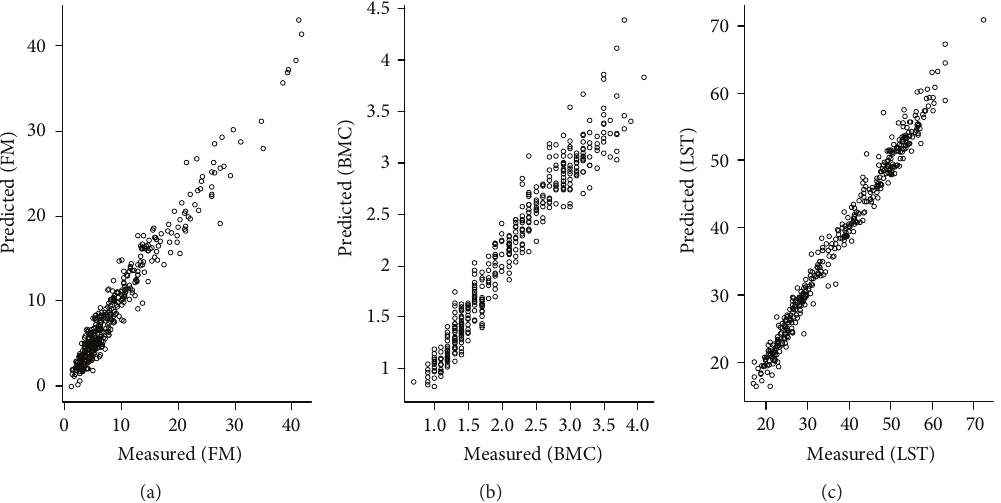
Figure 2: Scatterplot of predicted and actual fat mass (FM), bone mineral content (BMC), and lean soft tissue (LST) values in the male pediatric